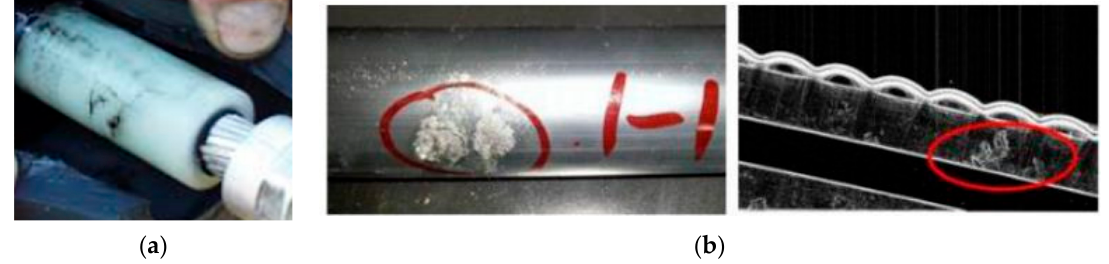
Figure 3. ( a ) Discharge at the distribution cable joint [59], ( b ) discharge at the buffer layer under corrugated aluminum sheath.